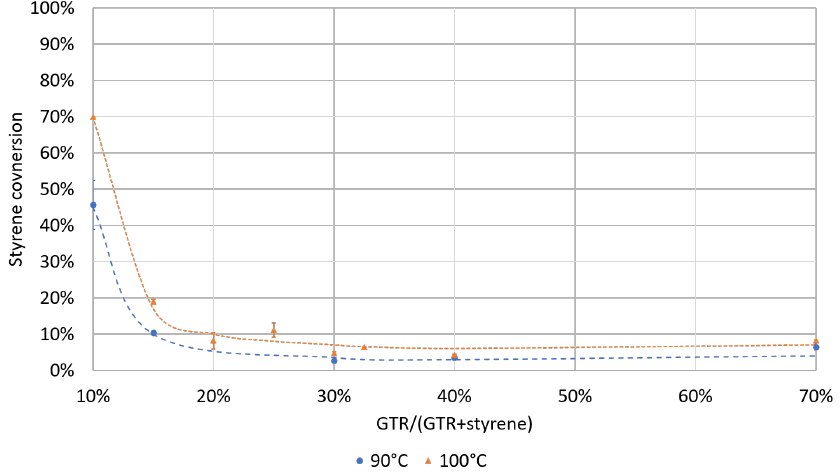
Figure 8. Effect of GTR/(GTR + styrene) and temperature for medium-sized system and BPO/styrene = 5.5% (dashed curves correspond to trend